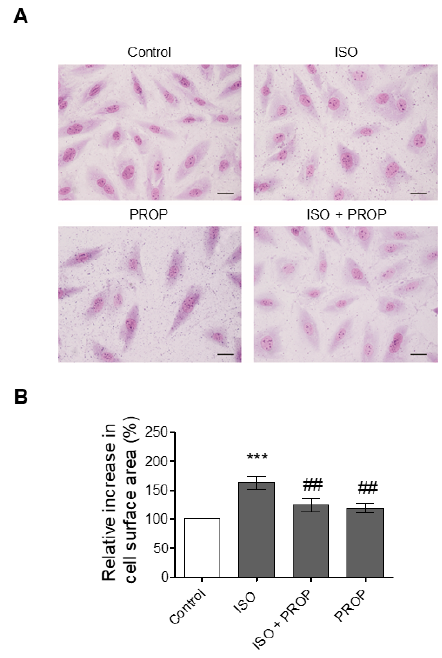
Figure 7. Effects of propranolol (PROP) on cardiomyocytes hypertrophy induced by isoproterenol (ISO) in vitro. ( A ) Morphological staining of H9c2 cells exposed to vehicle (indicated as Control), ISO (100 μ M), ISO + propranolol (PROP) (1 μ M) and propranolol (1 μ M) for 24 h. Scale bars: 25 μ m. ( B ) Cell surface area (%) of H9c2 cells exposed to vehicle (indicated as Control), ISO (100 μ M), ISO + propranolol (PROP) (1 μ M) and propranolol (1 μ M) for 24 h. Data are expressed as mean ± SEM derived from two independent measurements for each group. p < 0.001 (***) vs. Control group; p < 0.01 (##) vs. ISO group (one-way ANOVA and Newman-Keuls multiple comparison test).